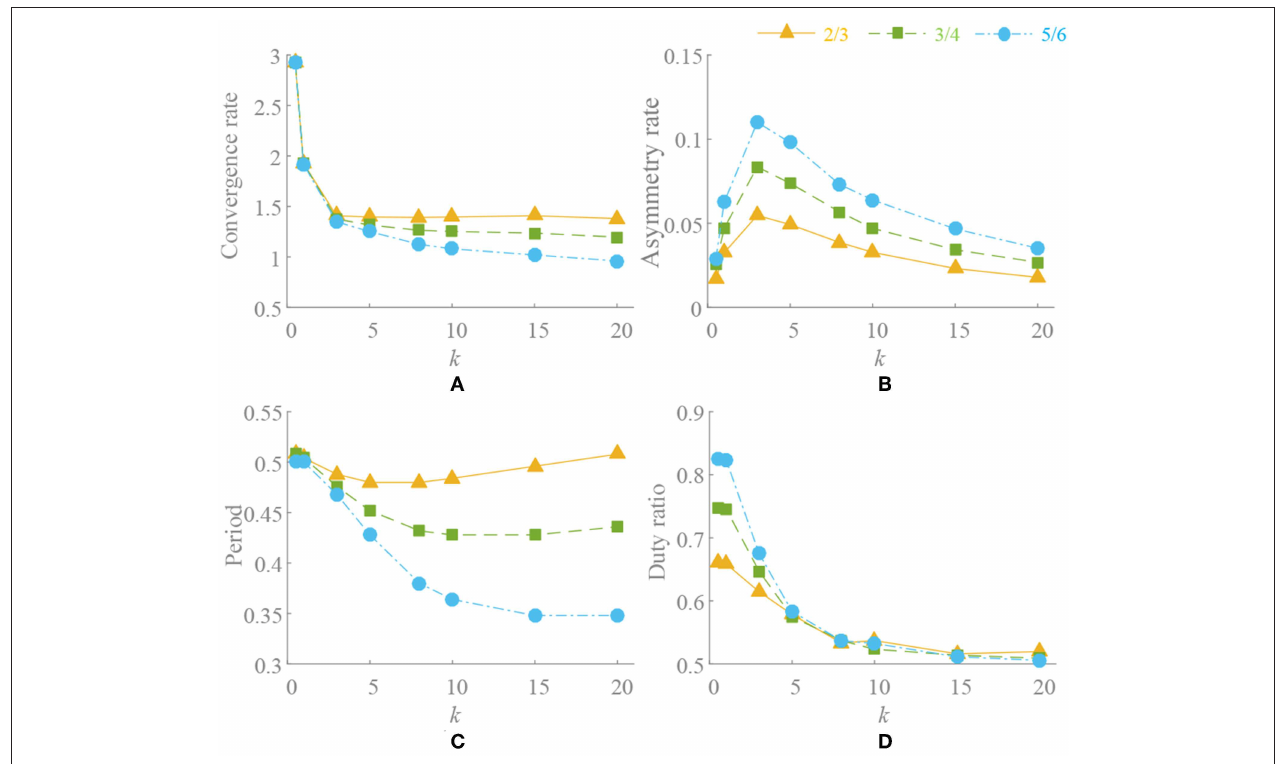
FIGURE 5 | Convergence and deformation of waveform. Oscillation period is set to T = 0.5s. k = [0.5, 1, 3, 5, 8, 10, 15, 20], ρ = [2/3, 3/4, 5/6]. (A) Convergence rate. (B) Asymmetry rate. (C) Period change. (D) Duty